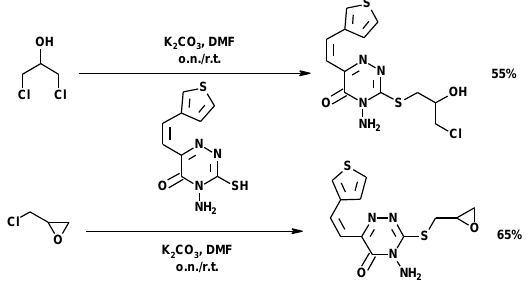
Figure 17. Synthesis of 1,2,4-triazine -thiophene- derivatives.